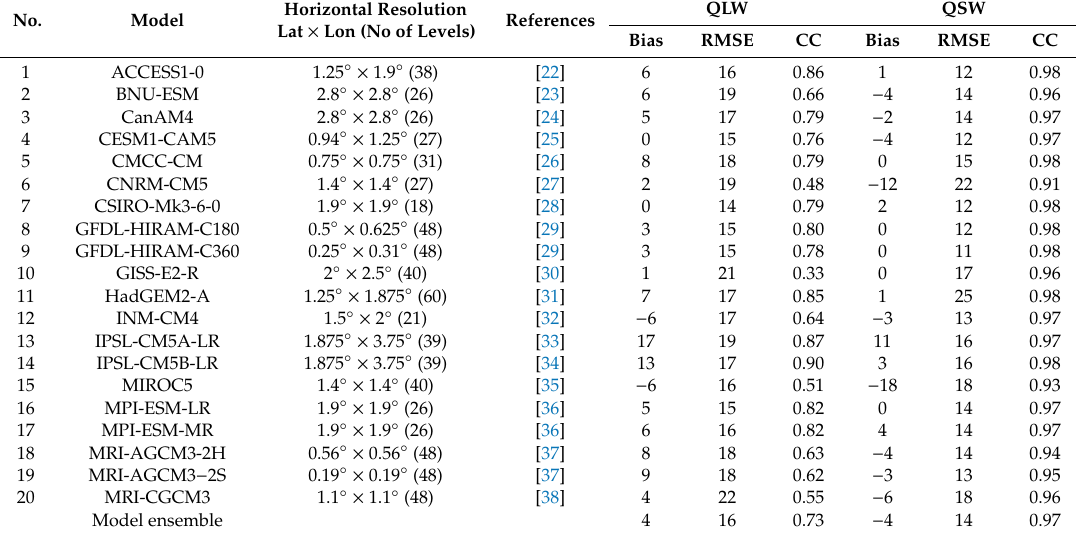
Table 1. Description of the 20 Atmospheric Model Intercomparison Project (AMIP) models used for this study along with the primary references. The bias and root mean squared error (RMSE, averaged over 30 ◦ S–30 ◦ N) are written to the closest W m − 2 . CC stands for the correlation coe ffi cient.